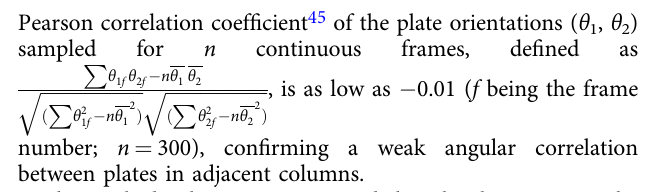
Fig. 2 Radially symmetric columns assembled from triangular plates. a Schematic and time-lapse optical microscopy images of the projections of the same column, overlaid with contour lines color-coded according to the local curvature (the inverse of the locally fi tted circle radius R ) 40 . The color bar represents curvature values. The fi rst-layer plate ’ s orientation θ is de fi ned as the angle of one long side of the plate relative to the horizontal axis. b The distribution of local curvature of the projection contours tracked at 0, 0.2, and 0.5 s in a . c Orientations of two plates (one in gray, the other in black) in a pair of nearest neighbor columns inside the lattice over time, and time-lapse optical microscopy images with the plate orientations labeled in yellow. The measurement errors are ±5°. d Time-lapse optical microscopy images (top) and corresponding Voronoi cell representations (bottom) of the hexagonal lattice, showing the annealing of imperfectly coordinated sites. The arrows in the top panel are color-coded by the velocity magnitude | v j | of columns calculated over a period of 0.7 s (12 frames). The color of each Voronoi cell denotes the number of nearest neighbors Z j per column j . e Radial distribution function of the lattice in experiment (green curve) and that of an ideal hexagonal lattice (gray lines). The inset de fi nes the center-to-center distance r between columns. A D value of 2.36 µ m is used in the plot. f The local order – local density ( j ψ j ; ρ j ) histogram based on single column tracking of the hexagonal lattice (32 6 j P Z j ¼ j 1 ð 6 i β Þj , where the summation goes over all the nearest neighbors of column j , and β j frames in Supplementary Movie 3). Here j ψ jk is the jk k ¼ 1 exp Z j 6 j angle between the bond linking column j and its k th neighbor and an arbitrary reference axis 46,47 . Ionic strength: 0.5 mM. Scale bars: 1 µ m in a ; 2 µ m in c ,